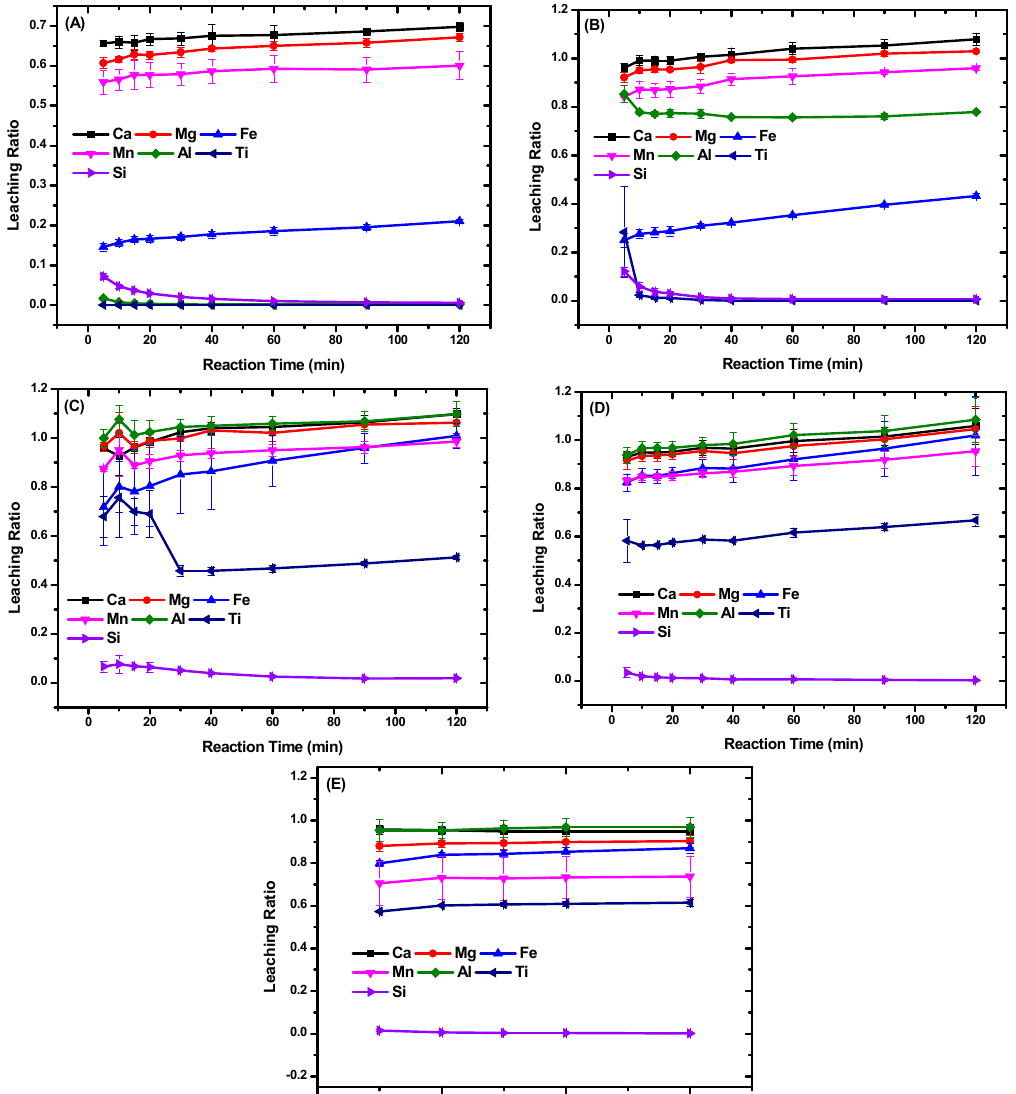
Figure 2. Effect of the variation in the AR concentrations of ( A ) 10%; ( B ) 20%; ( C ) 30%; ( D ) 40%; and ( E ) 50% with BFS suspended in DI water on the leaching ratio (LCH. R). With increasing AR concentration, the leaching ratio of metal ions increased with time.